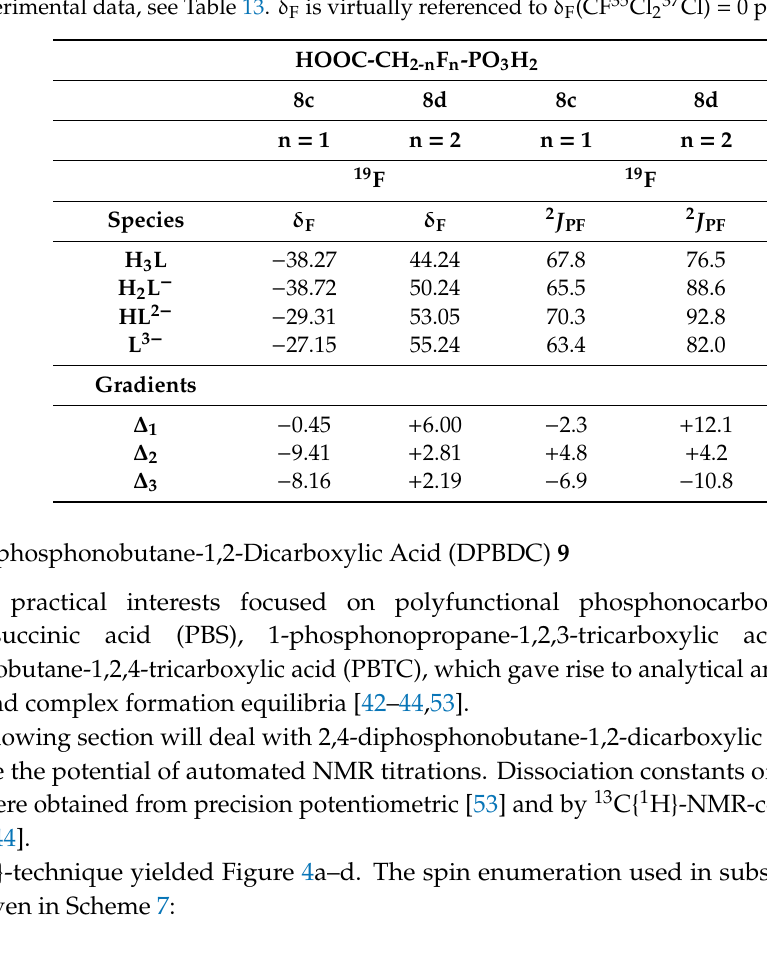
Table 13. Dissociation constants of fluorinated phosphonocarboxylic acids HOOC-CH 2- n F n -PO 3 H 2 ( 8c and 8d ; n = 1 and 2) obtained by the retro titration of LiOOC-CH 2- n F n -PO 3 Li 2 ( 8a and 8b ; n = 1 and 2) vs. HClO 4 . Experimental data: C Titrand : 0.85 mol/L 8a or 8b resp. C Titrator : 0.3928 mol/L HClO 4 . No ion buffer. Table 14. Chemical shifts δ F [ppm], coupling constants 2 J PF [Hz] and corresponding gradients of fluorinated phosphonocarboxylic acids HOOC-CH 2- n F n -PO 3 H 2 ( 8c and 8d , n = 1 and 2) obtained by 19 F-NMR-controlled titrations vs. HNO 3 of LiOOC-CH 2- n F n -PO 3 Li 2 ( 8c and 8d , n = 1 and 2). For experimental data, see Table 13. δ F is virtually referenced to δ F (CF 35 Cl 237 Cl) = 0